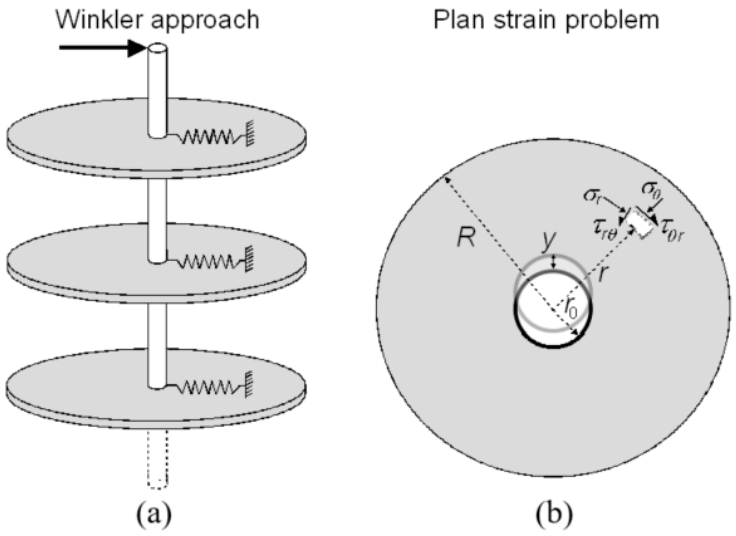
Figure 39. Schematic representation of idealized decoupled plane strain problem for studying soil–structure interaction: ( a ) modelling of laterally loaded pile according to the Winkler approach; ( b ) plane strain problem at a given depth.